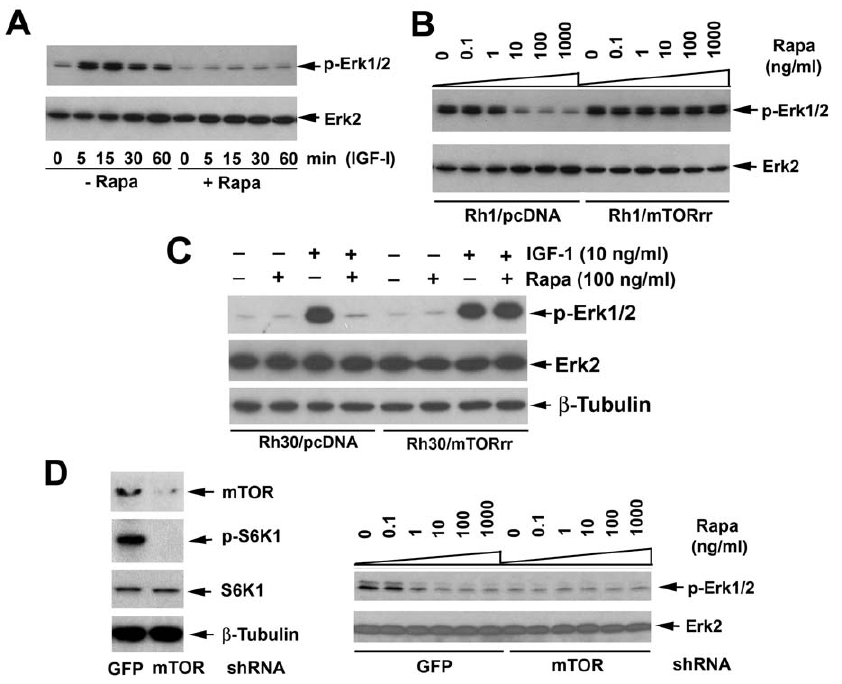
Figure 2. Rapamycin suppresses IGF-1 stimulated phosphorylation of Erk1/2 in an mTOR-dependent manner. (A) Serum starved Rh1 cells were pretreated with or without rapamycin (Rapa, 100 ng/ml) for 2 h, and then stimulated with IGF-1 (10 ng/ml) for the indicated time. (B) Serum-starved Rh1/pcDNA and Rh1/mTORrr cells were exposed to increasing concentrations of rapamycin (Rapa, 0–1000 ng/ml) for 2 h, and then to IGF-1 for 15 min. (C) Serum-starved Rh30/pcDNA and Rh30/mTORrr cells were pretreated with or without rapamycin (Rapa, 100 ng/ml) for 2 h, and then stimulated with or without IGF-1 (10 ng/ml) for 15 min. (D) Serum-starved Rh1 cells, infected with lentiviral shRNA to GFP (control) or mTOR, were stimulated with IGF-1 (10 ng/ml) for 1 h (Left panel), or exposed to increasing concentrations of rapamycin (Rapa, 0–1000 ng/ml) for 2 h, and then to IGF-1 for 15 min. For (A–D), cell lysates were analyzed by Western blotting using indicated antibodies.